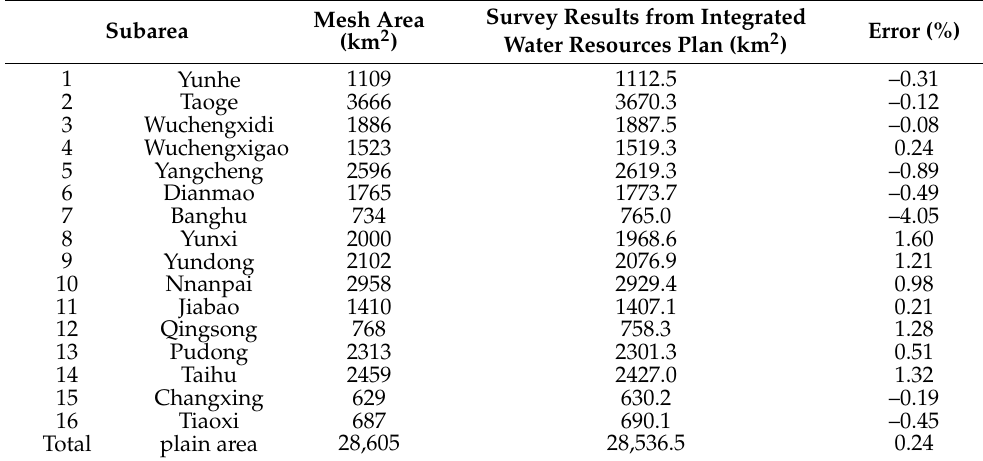
Table 2. Summary of area for 16 computational regions in the plain